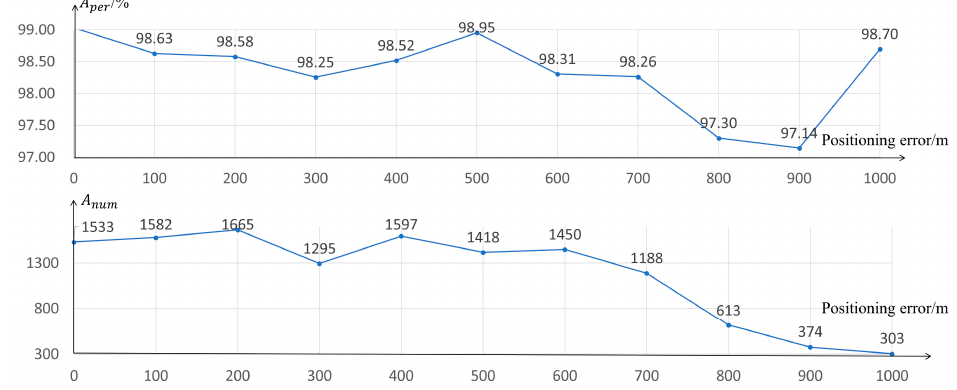
Figure 7. The performances of the proposed method against various positioning errors. The sub-figure of 𝐴 (cid:3041)(cid:3048)(cid:3040) shows that the inlier number is similar when the